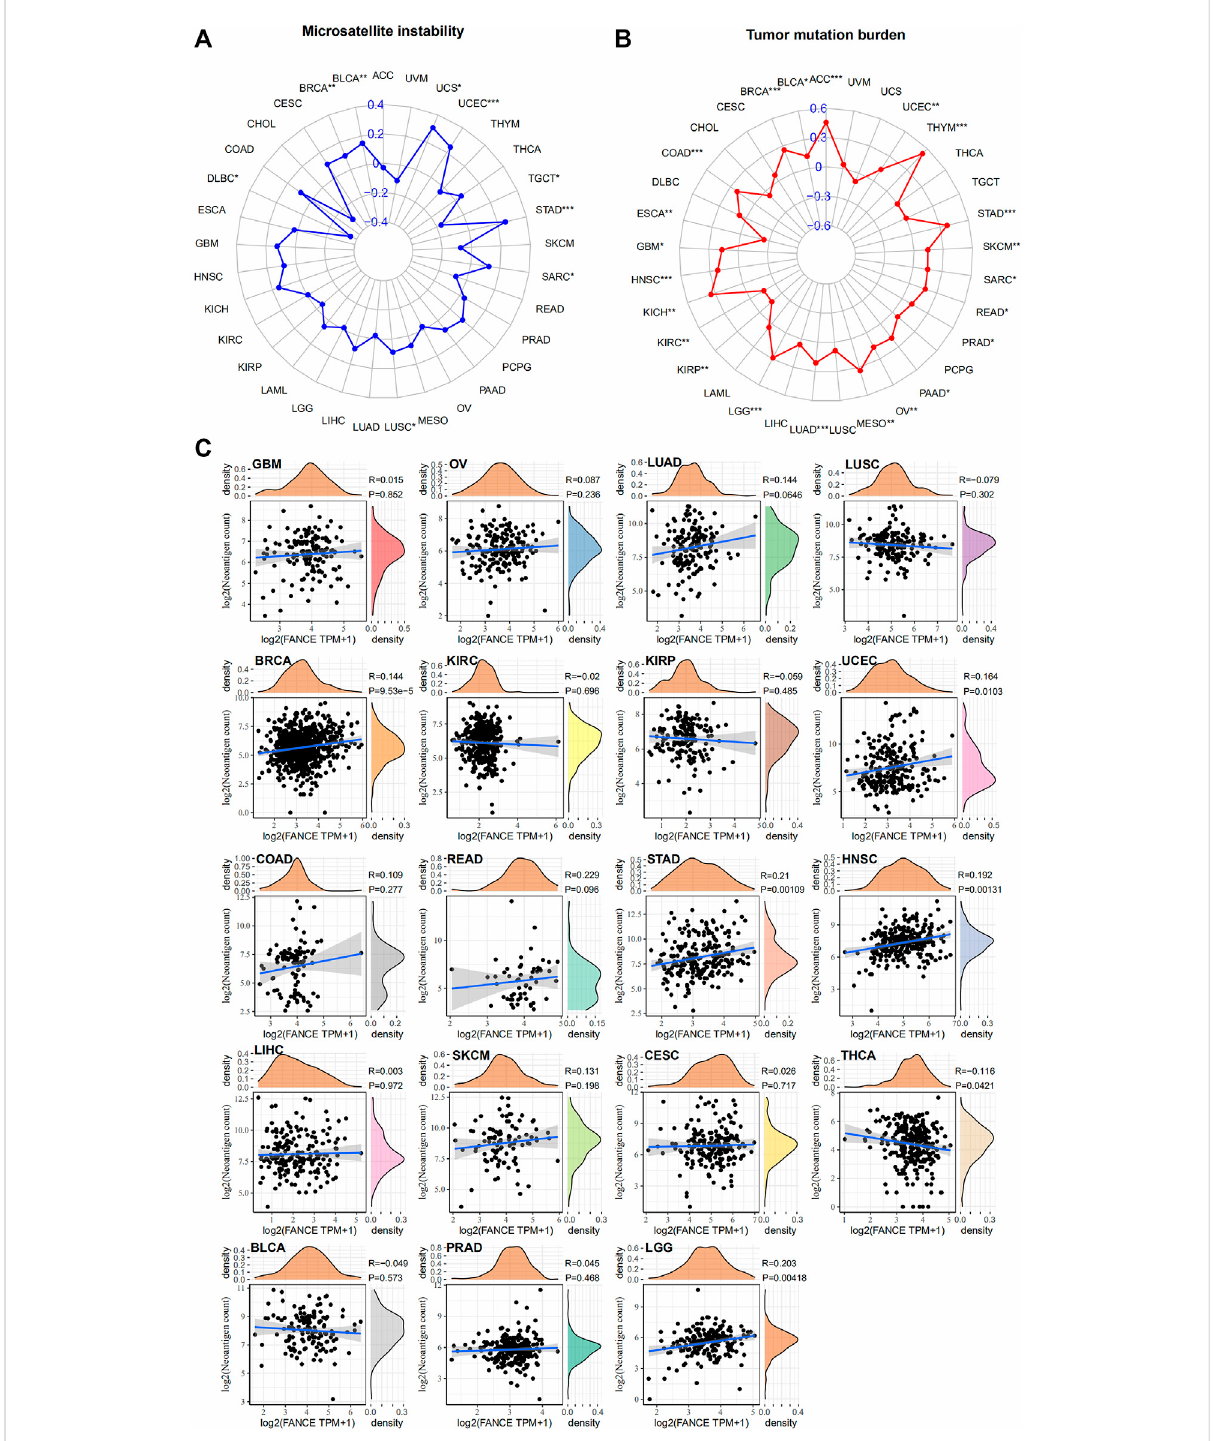
FIGURE 11 Correlation between FANCE expressionandmicrosatelliteinstability(MSI) (A) ,tumormutationburden(TMB) (B) ,andneoantigens (C) analysisin pan-cancer. * p < .05; ** p < .01; and *** p <